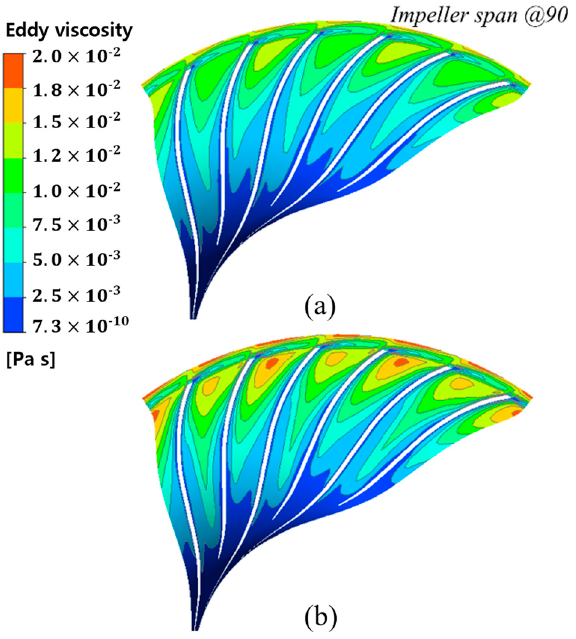
Figure 16. Eddy viscosity distribution between the ( a ) dry and ( b ) wet compression at the stall region .